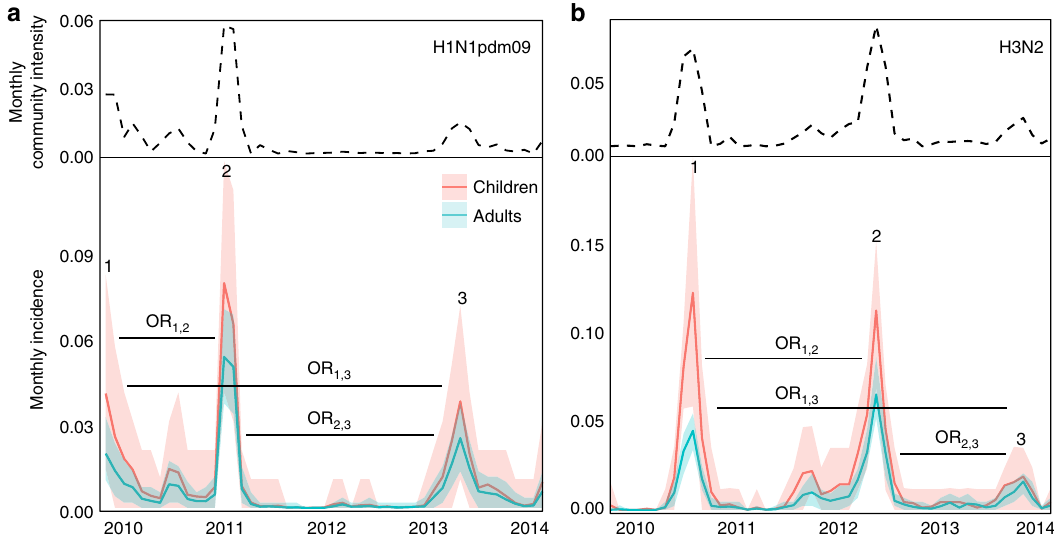
Fig. 3 Simulated monthly H1N1pdm09 and H3N2 incidence. Simulated monthly incidence for H1N1pdm09 ( a , bottom) and H3N2 ( b , bottom) in children and adults, averaged over 1000 simulations, contrasted with respective monthly community intensities ( a , b , top). The shaded areas are bounded by the 2.5 and 97.5% quantiles from the simulations. Horizontal black bars denote inter-epidemic periods for odds ratios (OR)